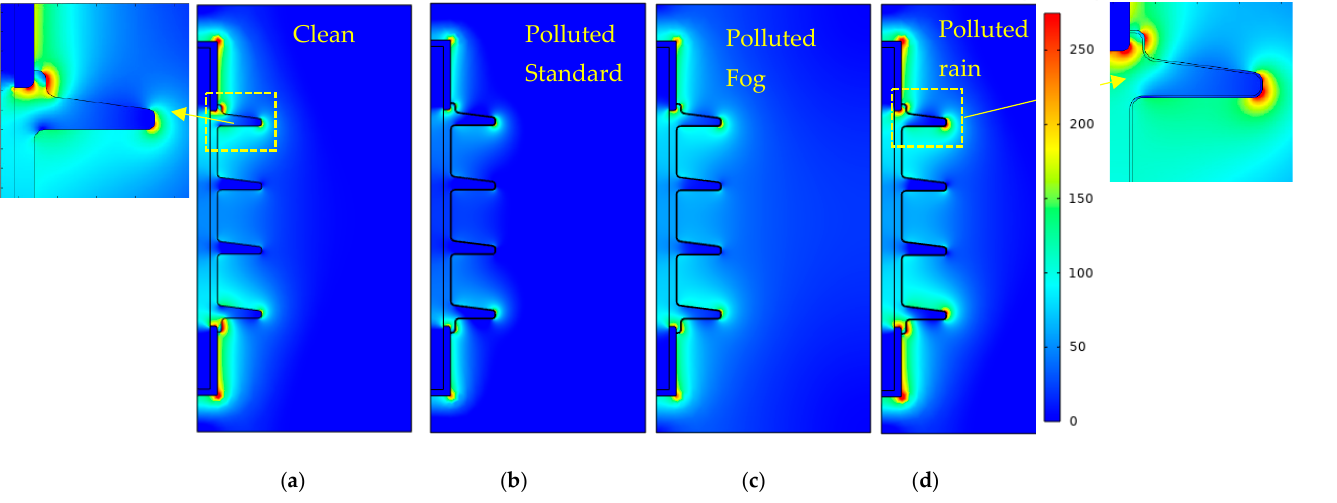
Figure 15. 2D Electric field distribution of insulators for: ( a ) Dry clean; ( b ) polluted (standard model); ( c ) Polluted (nonlinear model (fog)); ( d ) Polluted (nonlinear model (rain)).